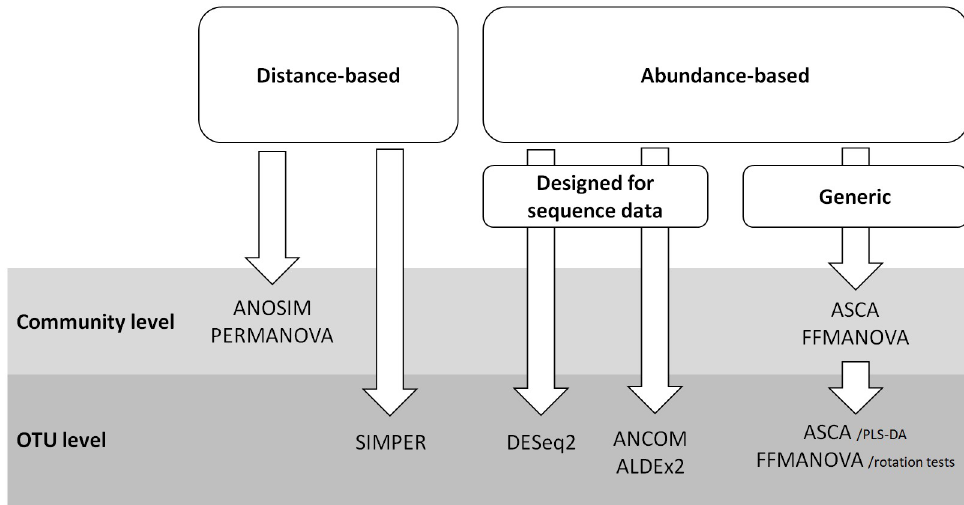
Fig 1. A diagram of statistical methods used in the